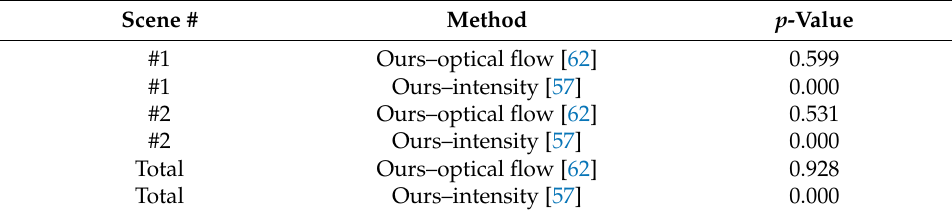
Table 5. Analysis of error statistics in a motion-controlled